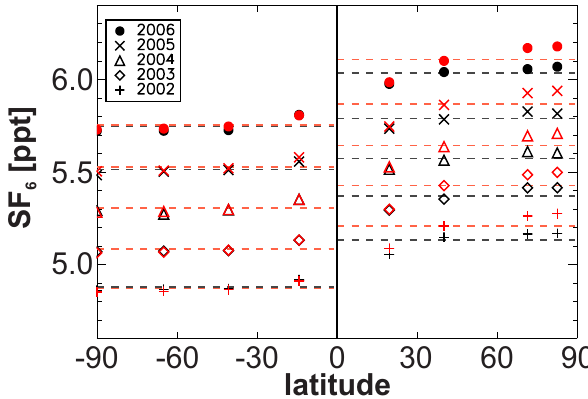
Fig. 3. Modelled and observed annual mean SF 6 concentrations (ppt) at different latitudes for the period 2002–2006. The black symbols represent observations at eight surface stations, while the red symbols show the equivalent modelled concentrations using the 5 . 6 ◦ × 5 . 6 ◦ model grid. Different years are represented by different symbols, as shown in the legend. The dotted lines represent the observed (black) and modelled (red) NH and SH mean concentration for each year.